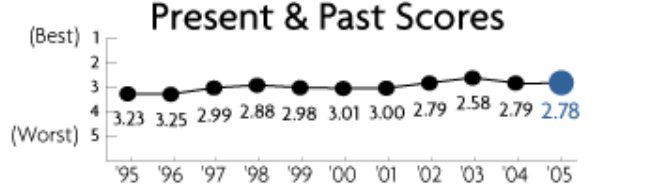
Figure 1 South Africa 's score: 2005 Index of Economic Freedom (Heritage